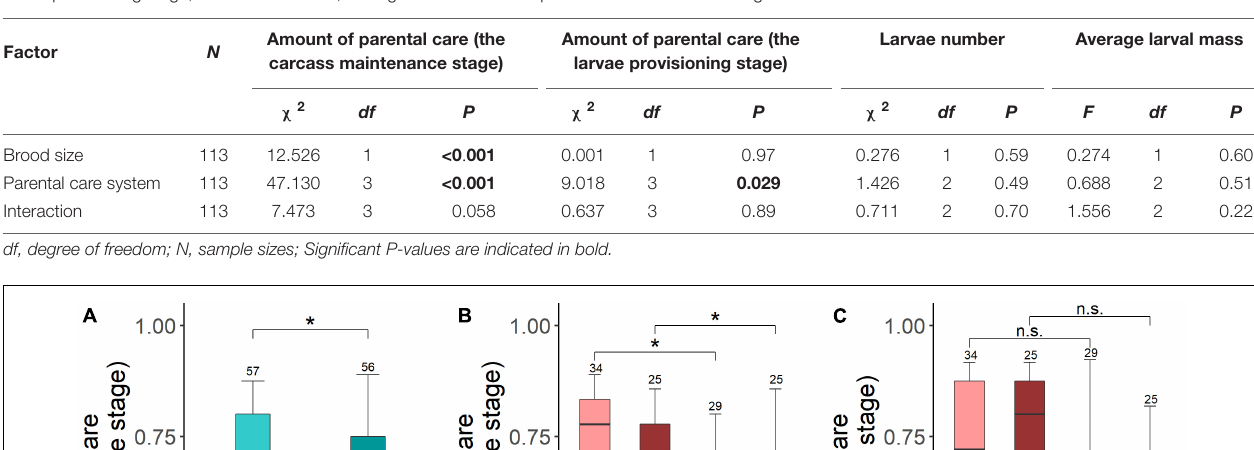
TABLE 5 | Effects of parental care system (parent traits: uniparental male, uniparental female, biparental male, biparental female; larvae traits: uniparental male, uniparental female, and biparental care) and brood size (5 vs. 15), and their interaction on the amount of parental care during the carcass maintenance stage and the larvae provisioning stage, and larvae number, average larval mass at dispersal in the second breeding.